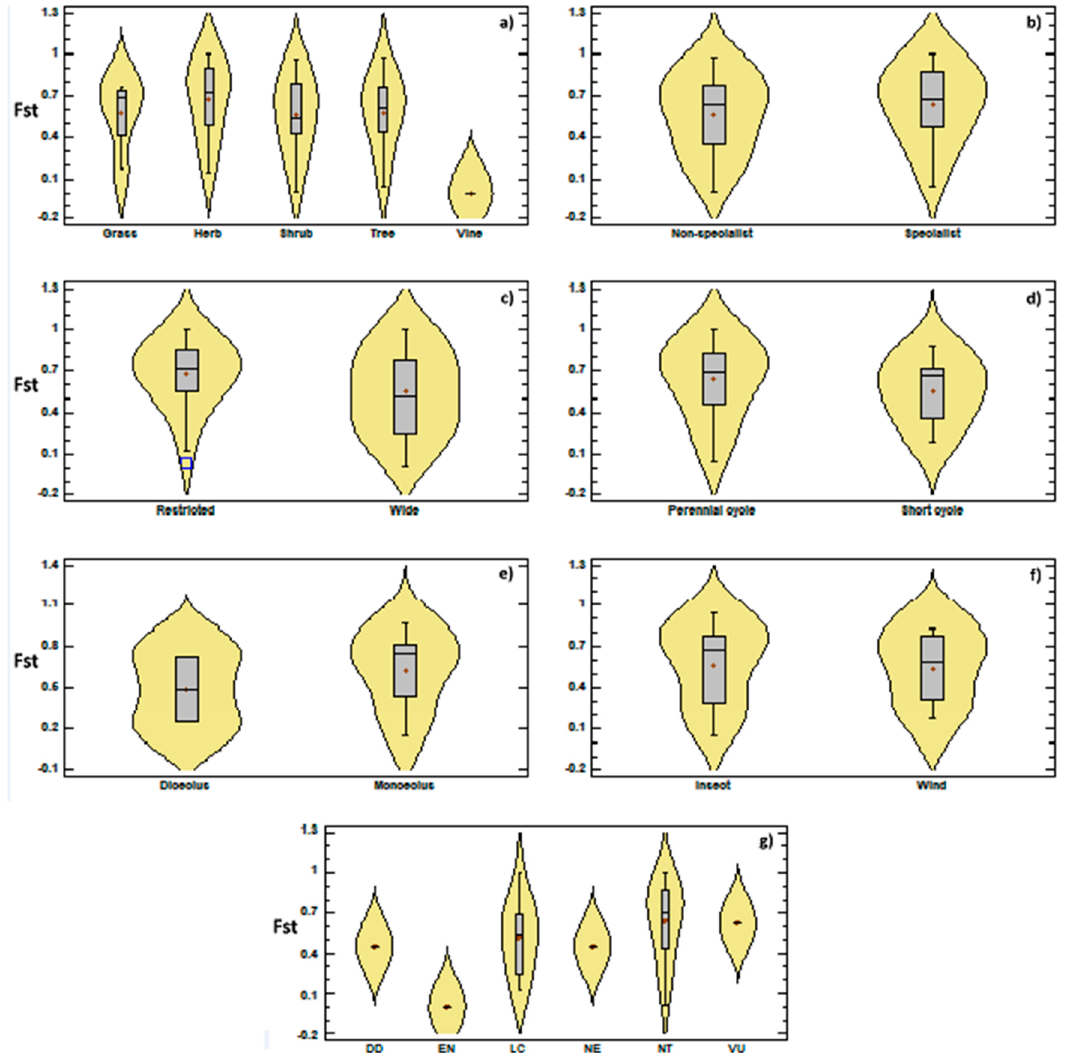
Figure 9. Mean Fixation index (Fst) observed in the different angiosperm groups targeted in studies that used chloroplast markers: ( a ) life mode; ( b ) habitat specialist/non-specialist; ( c ) geographic distribution; ( d ) reproductive cycle; ( e ) type of flower; ( f ) type of pollinator, and ( g ) IUCN category. + = average.